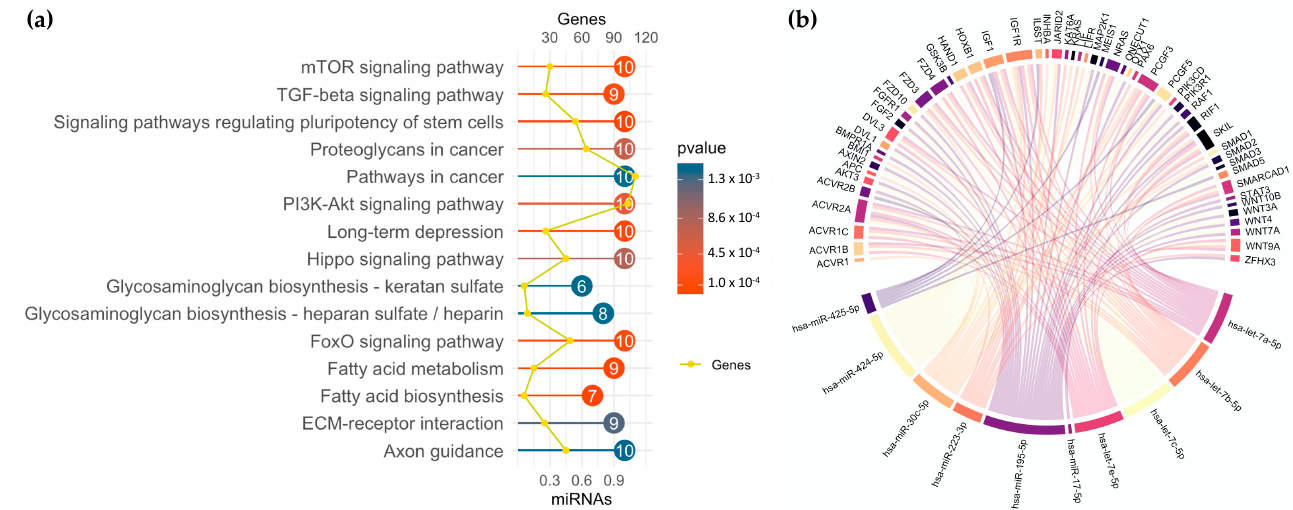
Figure 4. Bioinformatic analysis of the 10 most dysregulated miRNAs. ( a ) KEGG enrichment analysis of the 10 most dysregulated miRNAs. The x-axis reports the number of target genes and the fraction of miRNAs in the starting list involved in the pathway. The number within the dots represents the number of miRNAs. ( b ) The miRNA–target relationship in the KEGG_hsa04550 signaling pathway, “Signaling pathways regulating pluripotency of stem cells”. Each link represents a miRNA–target interaction.